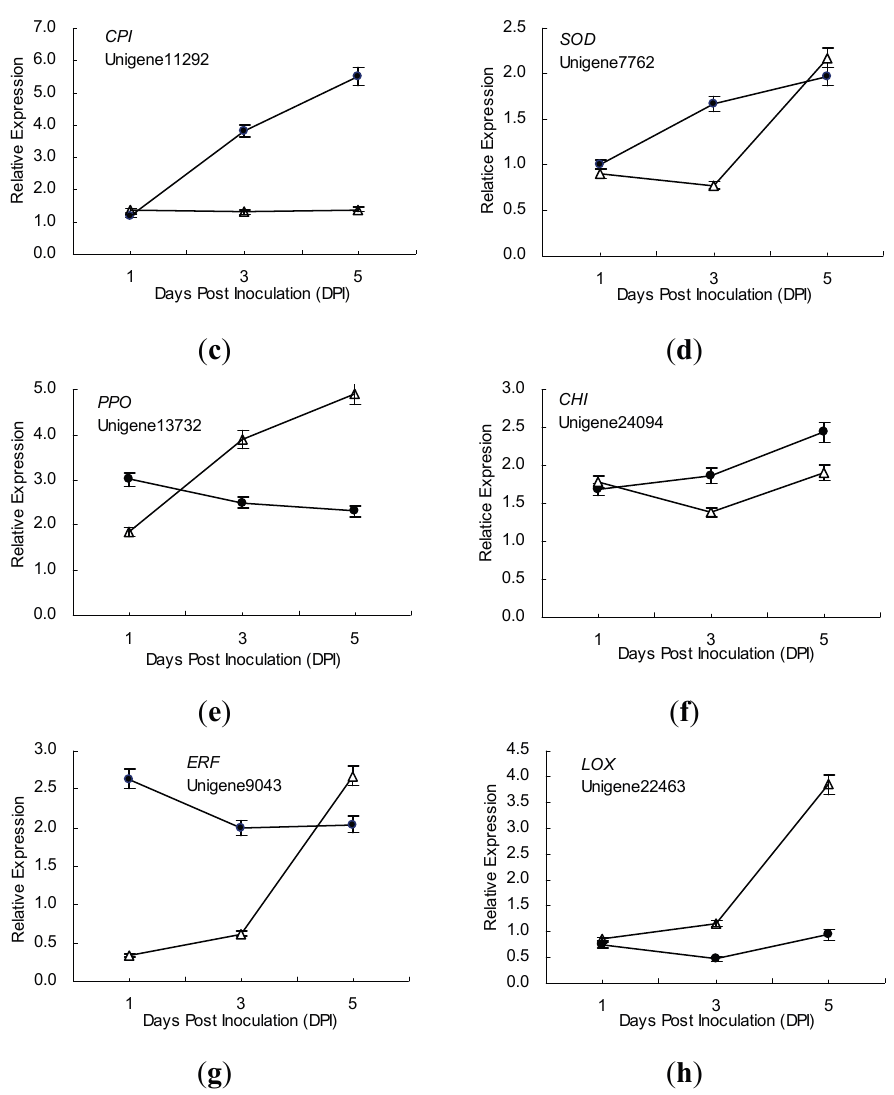
Figure 3. Time-course expression profiles of 8 defence-related genes in ramie roots during incompatible ( ● ) and compatible ( Δ ) interactions with P. coffeae revealed by qRT-PCR analyses. ( a ) TI , Trypsin inhibitor; ( b ) PI , Proteinase inhibitor; ( c ) CPI , Cysteine protease inhibitor; ( d ) SOD , Superoxide dismutase; ( e ) PPO , Polyphenoloxidase; ( f ) CHI , Chitinase; ( g ) ERF , Ethylene-responsive transcription factor; and ( h ) LOX , Lipoxygenase. Data from qRT-PCR are means of three biological replicates (each has 2 experimental replicates) and bars represent standerd